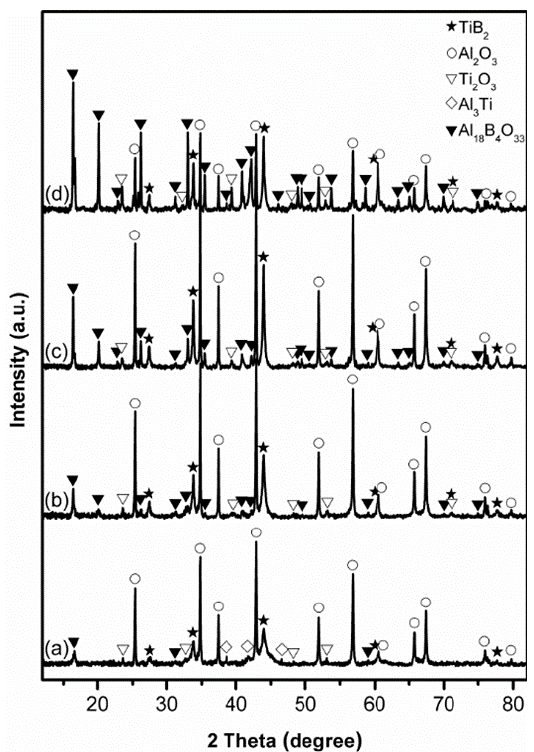
Figure 2. XRD patterns of stoichiometric samples after 4 h firing in NaCl at: ( a ) 850, ( b ) 950, ( c ) 1050, and ( d ) 1150 °C.